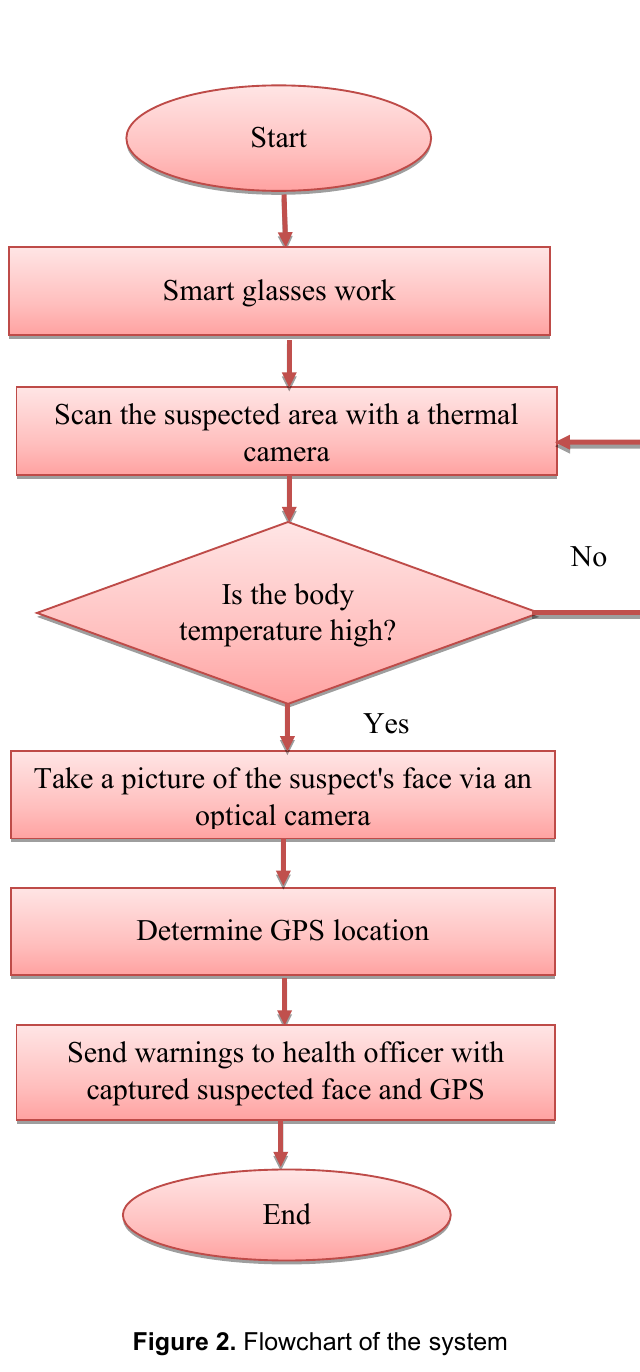
Figure 2. Flowchart of the